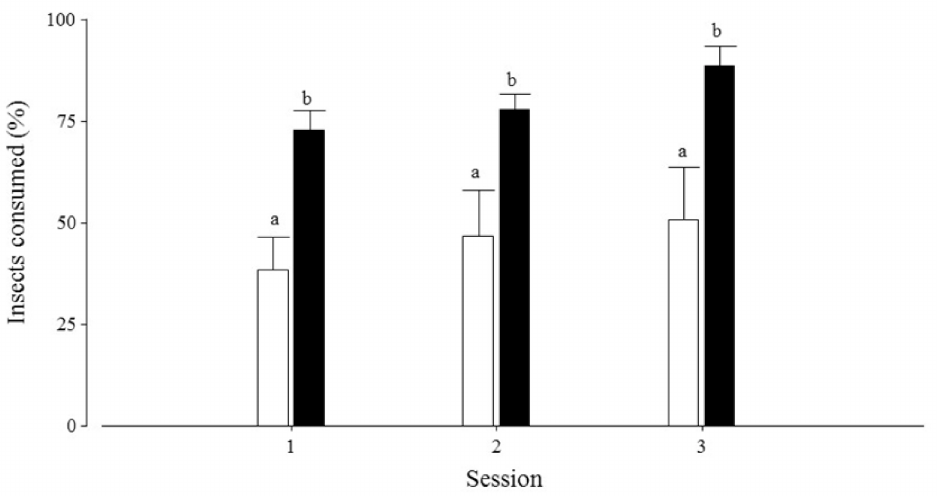
Figure 4. Percentage of insects consumed by the lesser anteaters in each of the three sessions of the behavioral evaluation. Each session lasted 10 min. Ants are represented in white and termites in black. Different letters indicate statistical differences between the insects consumed by the lesser anteaters within each session ( p < 0.05).